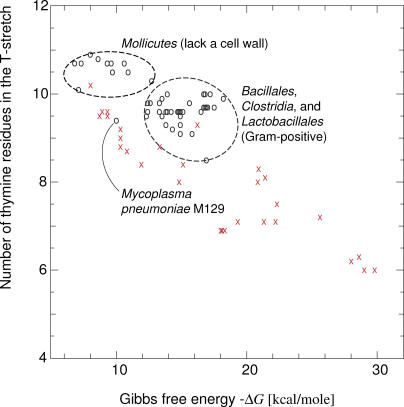
Average Gibbs Free Energy of Stem-Loop Formation and the Average Number of Thymine Residues in the T-StretchThese are calculated from the predicted Rho-independent terminators in the 82 bacterial species we consider. Circles represent organisms belonging to the Firmicutes phylum; crosses represent other bacterial species.